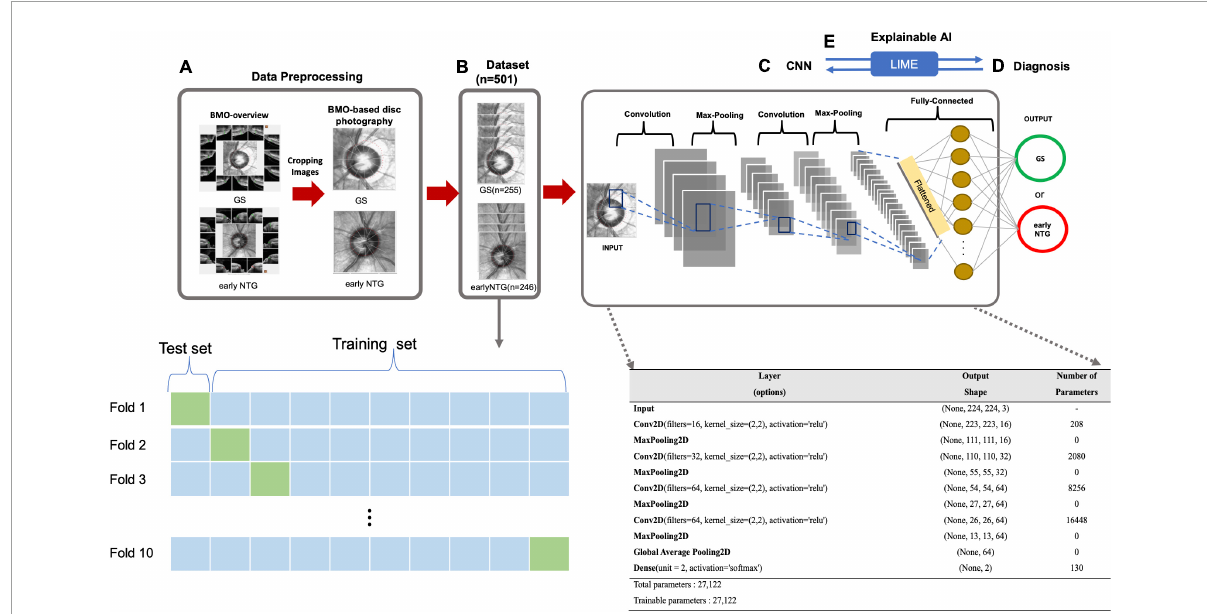
FIGURE2 Diagnostic workflow based on the CNN. (A) Data preprocessing. BMO-based disc photographs including disc margin (dotted line) were extracted from BMO Overview with a size of 438 × 436 pixels using the Pillow library in Python. (B) Dataset. The dataset contains a total of 2 classes with 501 eyes (501 subjects), either early NTG (246 subjects) or GS (255 subjects). 10-fold cross validation was performed to compensate for the relatively small number of dataset. For each iteration, there are 399 images in training set, and 102 BMO-overview images are in test set. (C) CNN. A convolutional neural network structure was built from scratch on the Keras Sequential API (https://keras.io/) for the diagnosis of early NTG. The model input was taken as a tensor with dimensions of (244, 244, 3). The first and second hidden layers of the model had 16 and 32 filters, respectively, with a kernel size of (2, 2), and a ReLU was taken as the activation function. The third and fourth hidden layers had 64 filters with a kernel size of (2, 2) and ReLUs. The model contained a fully connected dense layer with 2 units and softmax was taken as its activation function. The batch size was 10, and the number of epochs was 100 in the model. For compiling the model, Nadam (32) and categorical cross-entropy were taken as the optimizer and loss function, respectively. (D) Diagnosis. The AI model diagnosed the input images from the test set as either early NTG or GS. (E) Explainable AI. Explainable AI (XAI) is artificial intelligence that can be explainable and understandable the predictions or decisions that made by the AI. LIME was applied to understand the decisions of deep learning black-box models. By comparing with the diagnostic criteria of the clinician, the reliability in the diagnosis of the deep learning model can be